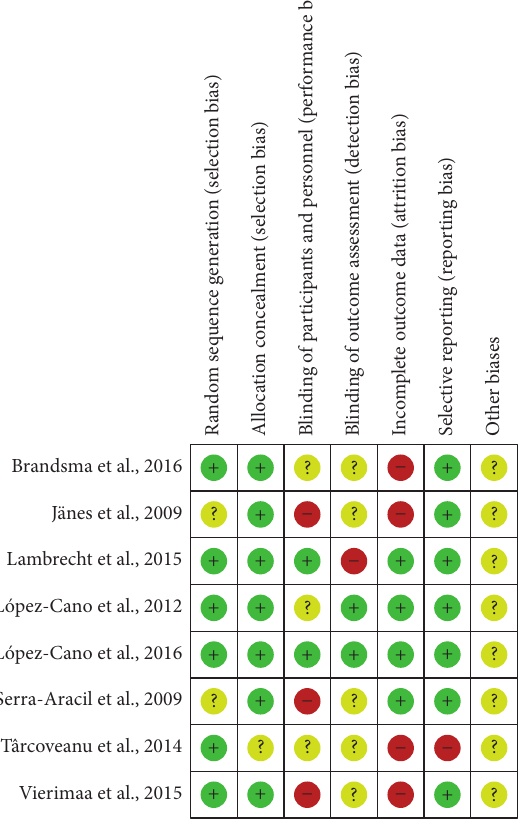
Figure 2: Risk of bias summary: author’s judgement about risk of bias according to the Cochrane Risk of Bias Tool. +, high quality, − , low quality, and ?, unable to determine.